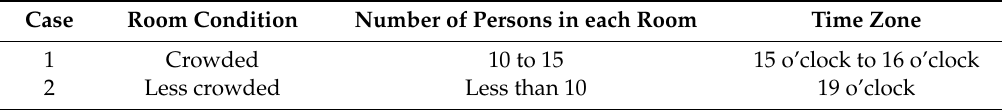
Table 2. Measurement cases of sound during hotel operations.